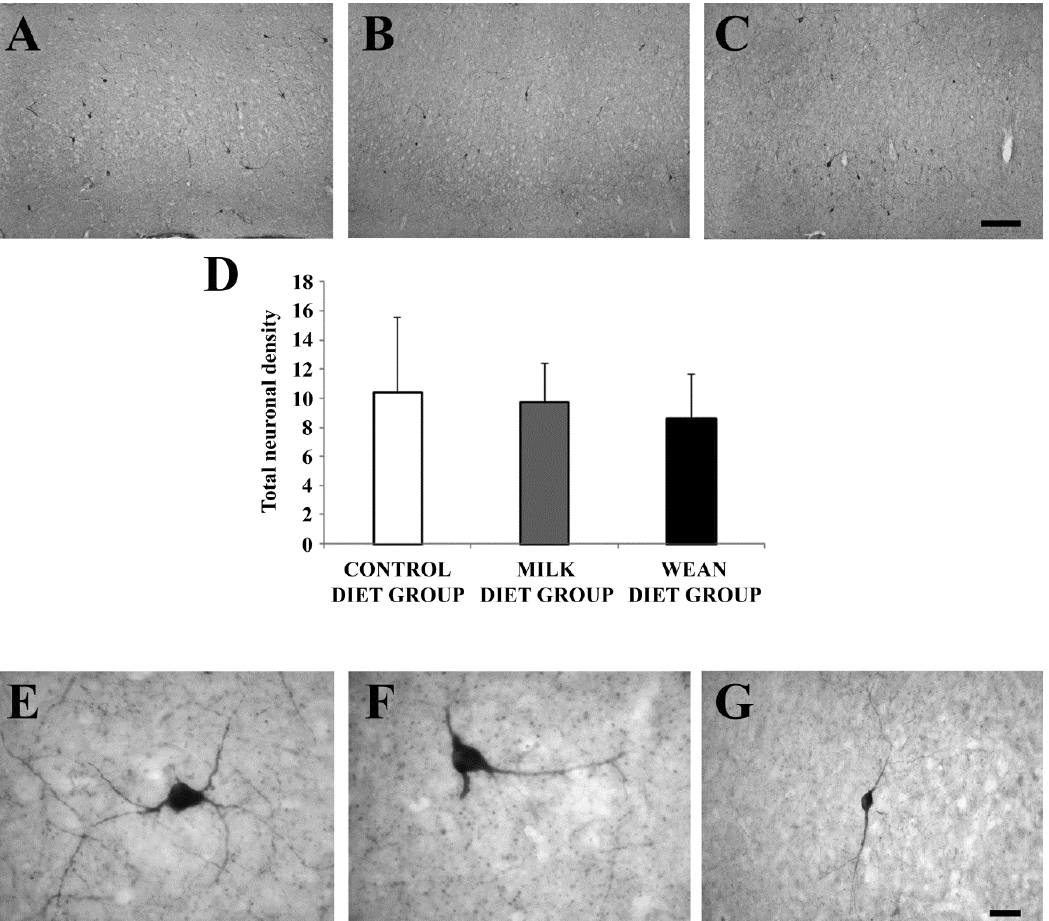
Figure 4. Brightfield photomicrographs of coronal sections ( A – C ) and histogram ( D ) showing the distribution of neuronal nitric oxide synthase (nNOS) immunoreactivity in the prefrontal cortex of the control diet group ( A ), milk diet group ( B ), and wean diet group ( C ). Comparison among the three groups shows no significant difference in neuronal densities (number of somata/mm 2 ; A – D ). In every group, nitrergic cells are non-pyramidal neurons with angular-( E,F ) or fusiform-( G ) shaped cell body. Scale bars = 200 µm in C (applies to A – C); 20 µm in G (applies to E – G).